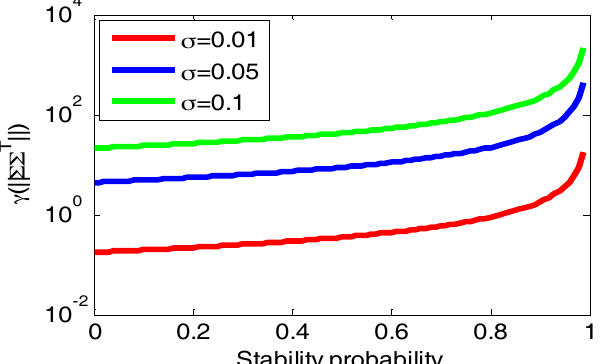
Figure 4. The relation between stability probability and γ (|| ΣΣ T ||).